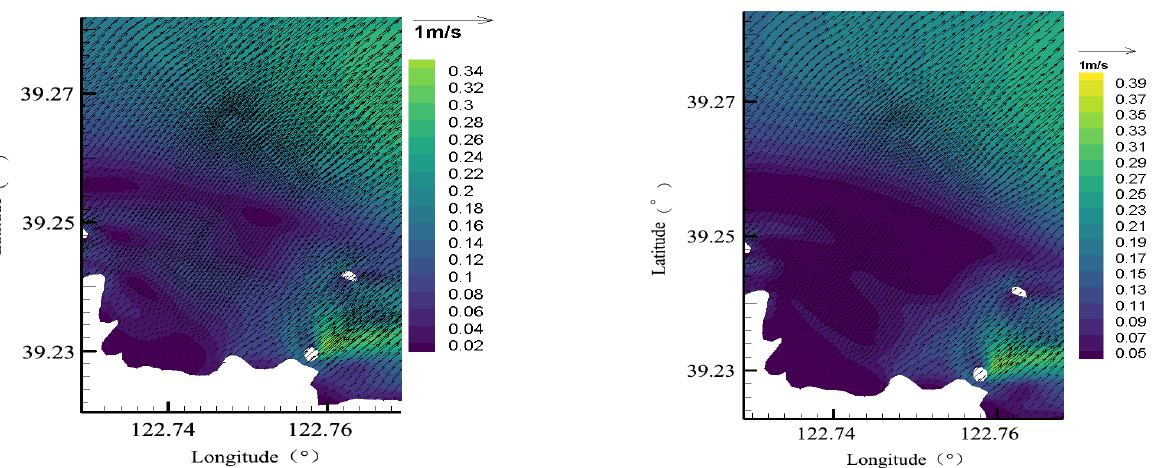
Figure 11. Flow field distribution at the peak of a flood tide.